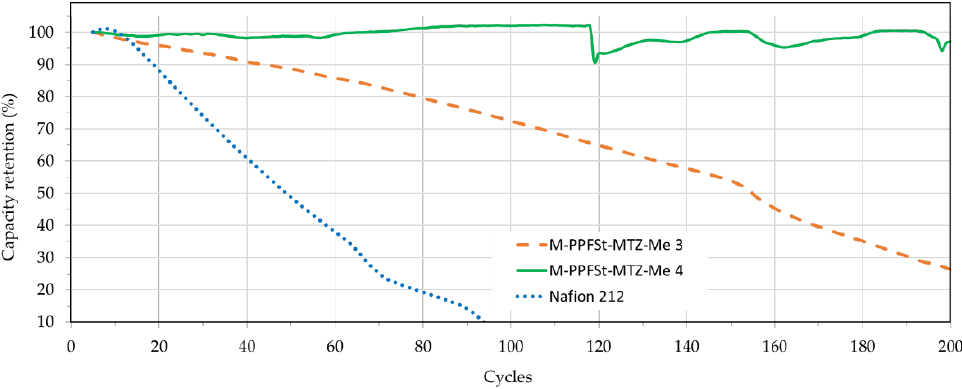
Figure 7. Open circuit voltage (OCV) of VRFBs with Nafion and blend membranes as a function of time.